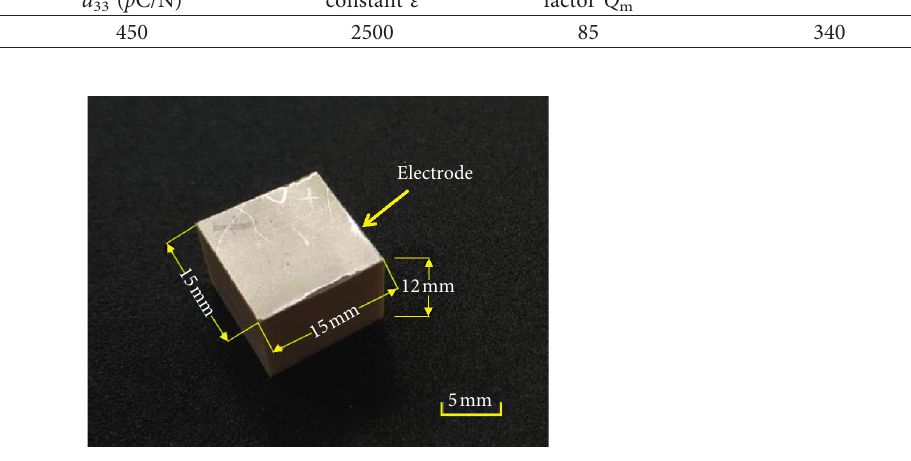
Figure 1: Photograph of a typical specimen of P51.